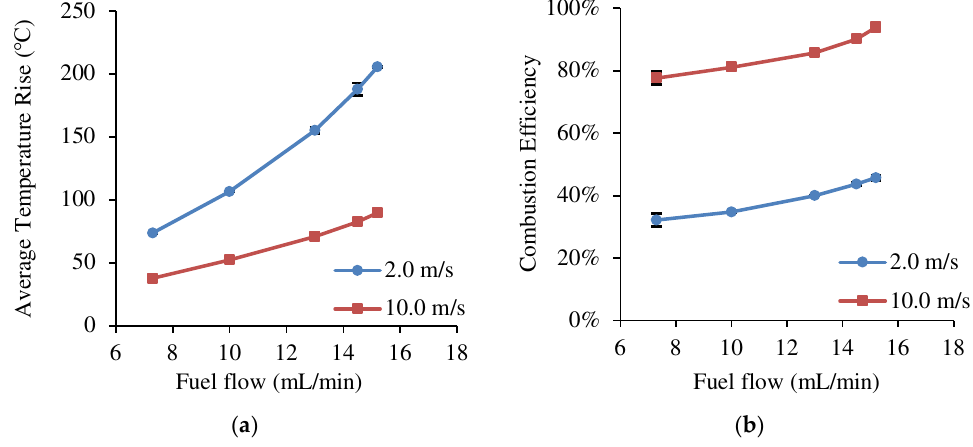
Figure 13. ( a ) The average temperature rise and ( b ) the combustion efficiency in the exhaust pipe with the air flow velocity of 2.0 m/s and 10.0 m/s.